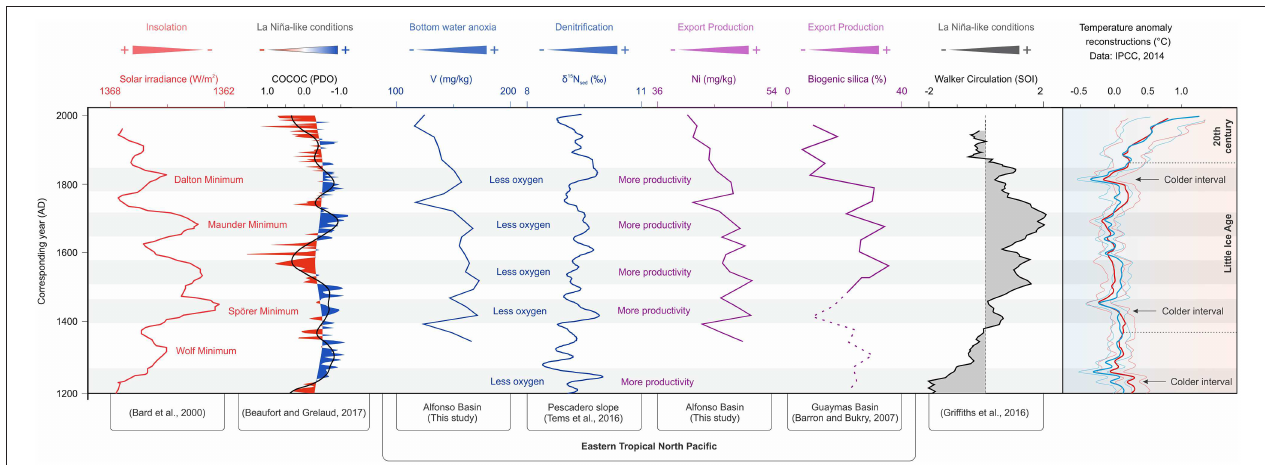
FIGURE 8 | Reconstruction of OMZ variability of the Eastern Pacific during the last 800 years based on proxies for water column denitrification, redox and productivity compared to major climatic forcings. Note that the solar irradiance plot is inverted for better